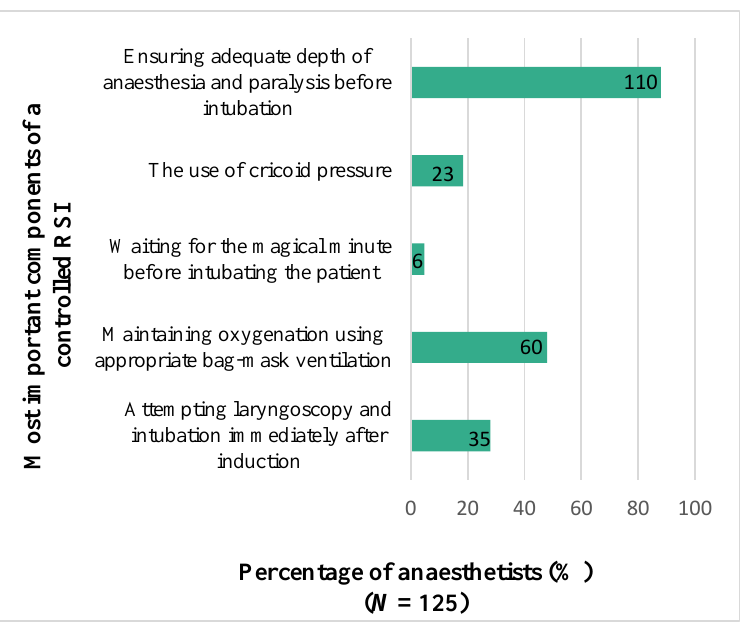
Figure 2. Choice on most important RSI components.